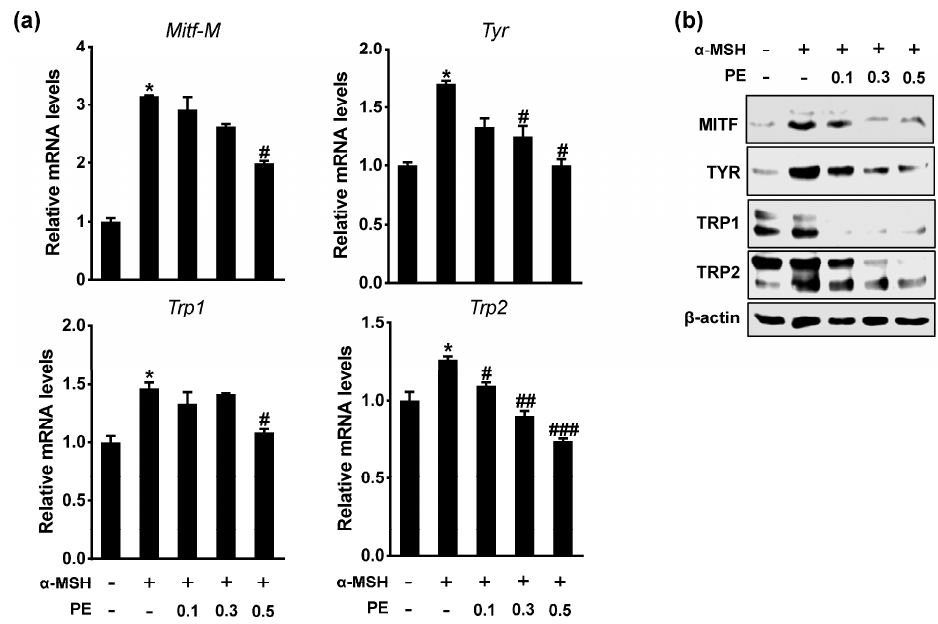
Figure 2. Effects of PE on expression of melanogenic genes. B16F10 cells were exposed to α -MSH in presence or absence of PE (mg/mL) for 24 h. ( a ) mRNA levels for Mitf-M , Tyr , Trp1 , and Trp2 were analyzed by RT-qPCR. * p < 0.05 vs. control; # p < 0.05 vs. α -MSH; ## p < 0.01 vs. α -MSH; ### p < 0.001 vs. α -MSH. Data are mean ± SEM; n = 3; ( b ) Cell lysates were analyzed for microphthalmia-associated transcription factor (MITF), tyrosinase (TYR), tyrosinase-related protein 1 (TRP1), and tyrosinase-related protein 2 (TRP2) protein levels by immunoblotting.